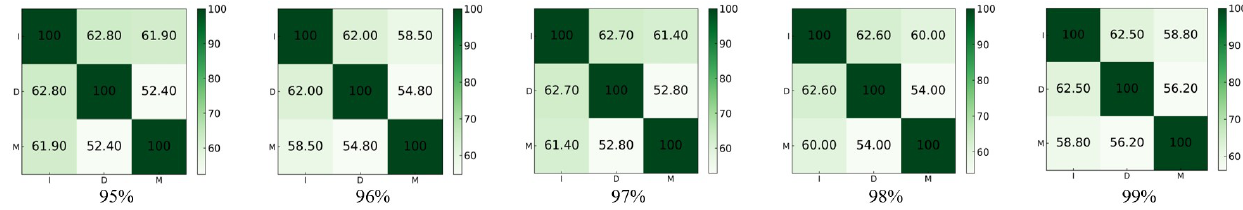
Figure 10. The similarity matrix with different accuracy.